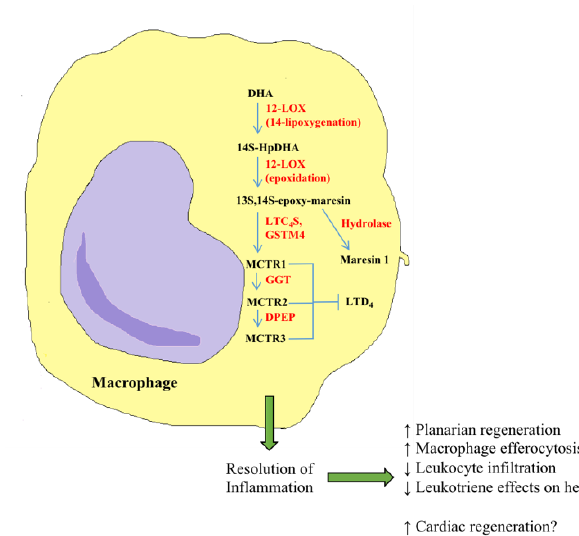
Figure 4. Maresin biosynthetic pathways in the resolution of inflammation. In human macrophages,